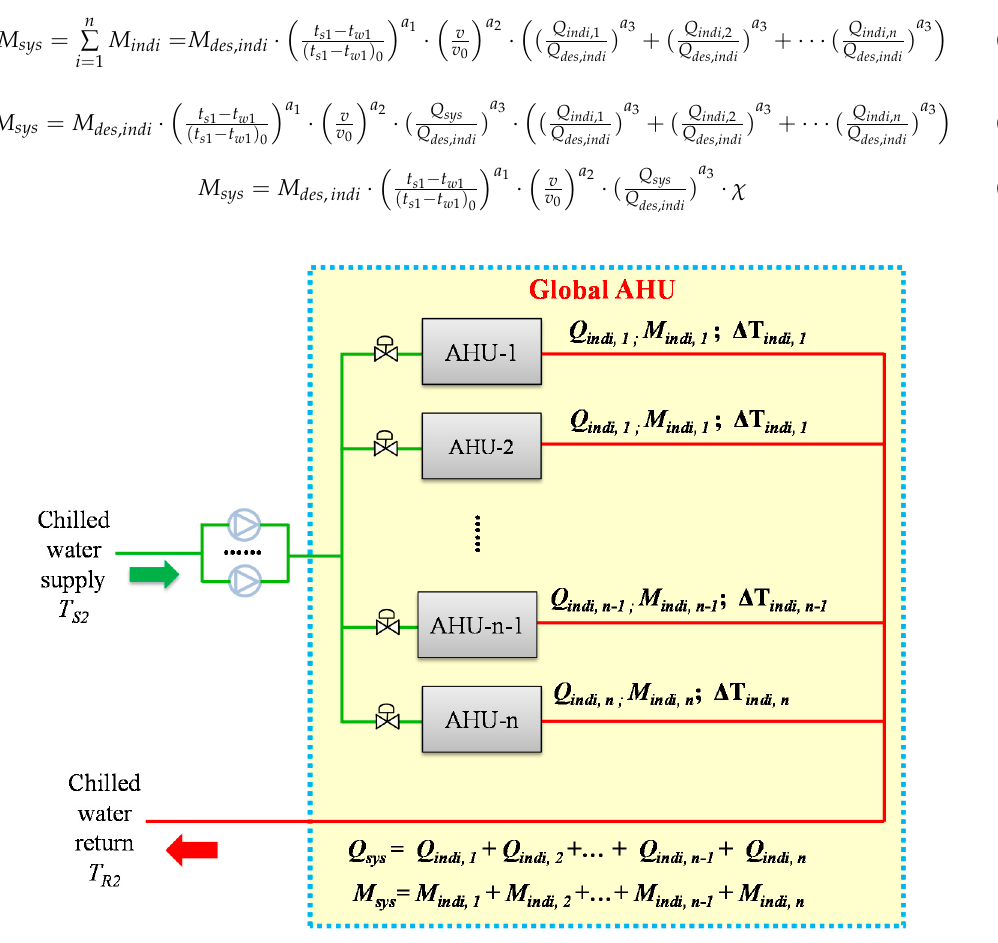
Figure 2. Scheme for development of global air handling unit (AHU) model.